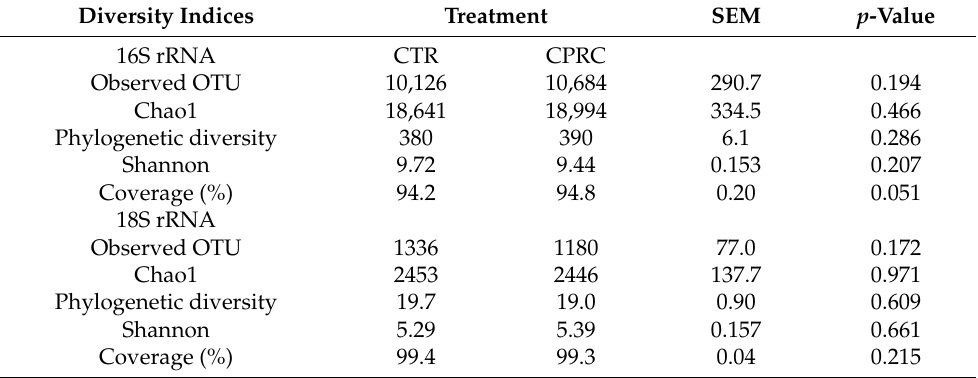
Table 5. Effect feeding cold-pressed rapeseed on ruminal microbiota diversity measurements in lactating